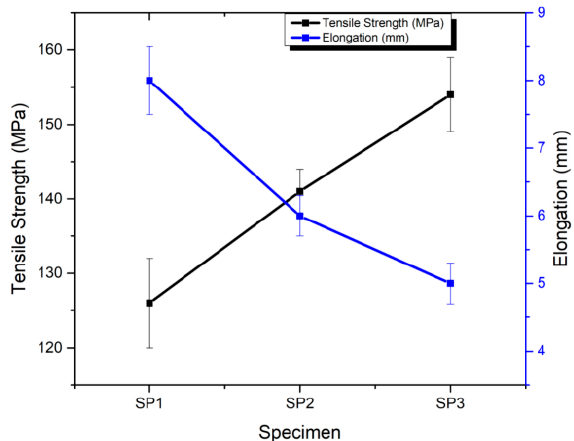
Figure 4. Tensile strength of the tested specimen.